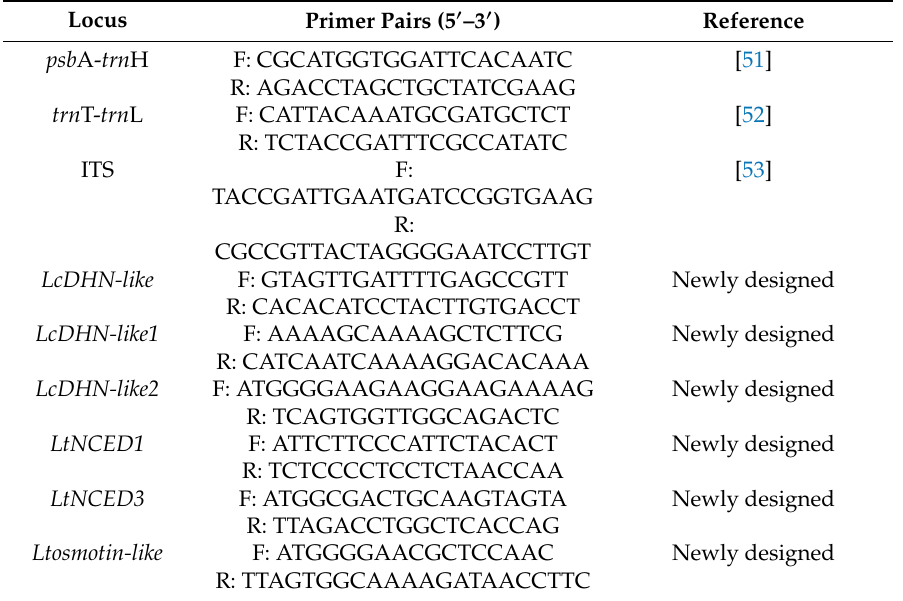
Table 2. All locus primers used in this